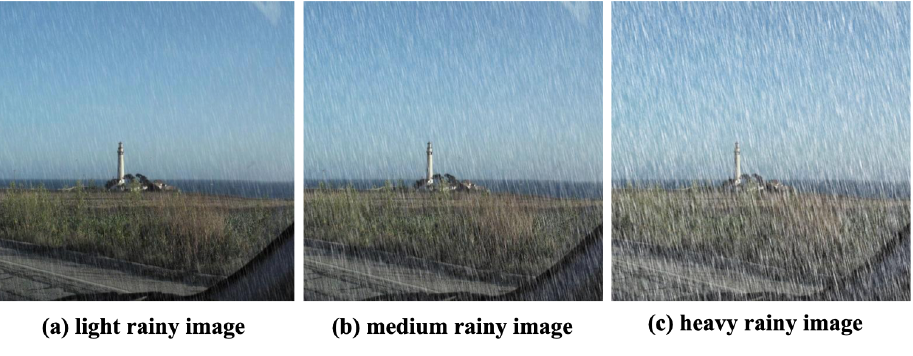
Figure 1. Rainy image